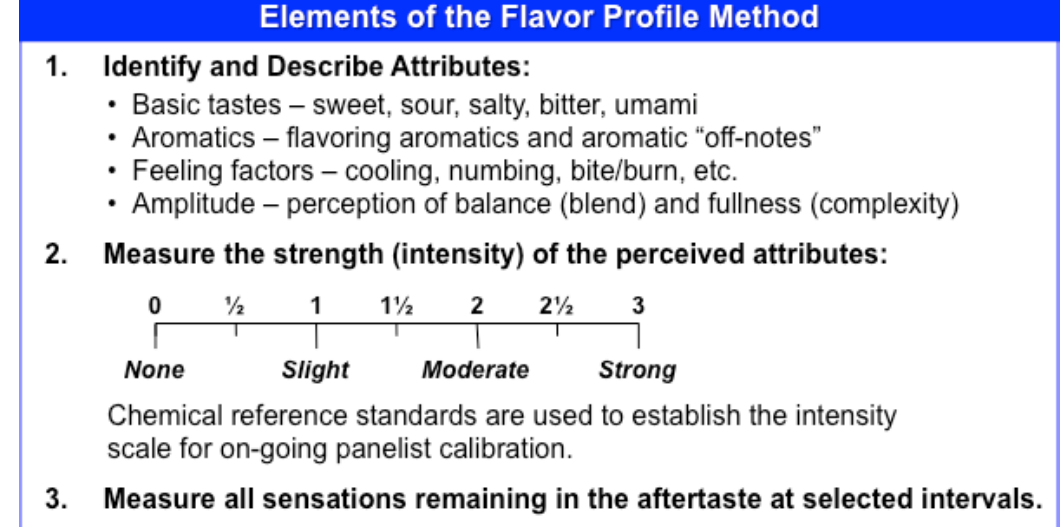
Figure 7. Flavor profile definitions.